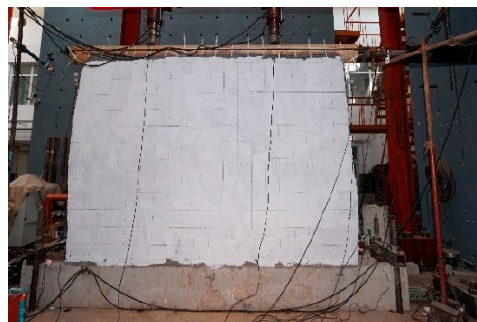
Figure 9. Specimen